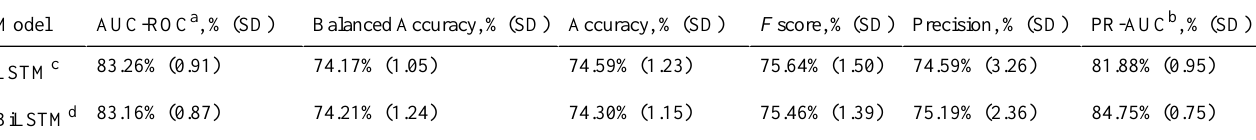
Table 5. LSTM and BiLSTM Classifiers performance trained with longitudinal data for current HbA 1c levels